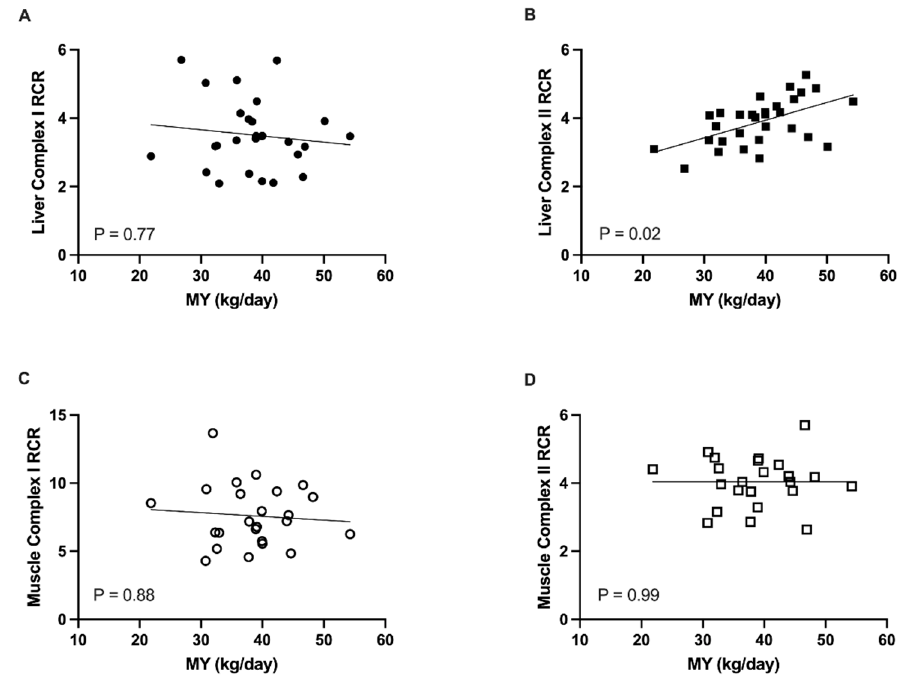
Figure 1. Mitochondrial respiratory control ratio (RCR) for ( A ) liver complex I, ( B ) liver complex II, ( C ) skeletal muscle complex I, and ( D ) skeletal muscle complex II in association with milk yield (MY). RCR, calculated as mitochondrial maximal to resting respiration rate, is a measure of mito- chondrial coupling efficiency. Circles represent complex I mediated respiration and squares repre- sent complex II respiration. Closed symbols indicate liver tissue whereas open symbols denote skel- etal muscle tissue. MY was recorded as total kg produced the day before biopsy. Tissue biopsies were collected at 8 ± 2 DIM (early), 75 ± 4 DIM (peak), and 199 ± 6 DIM (late) lactation on 11 multip- arous Holsteins per timepoint.